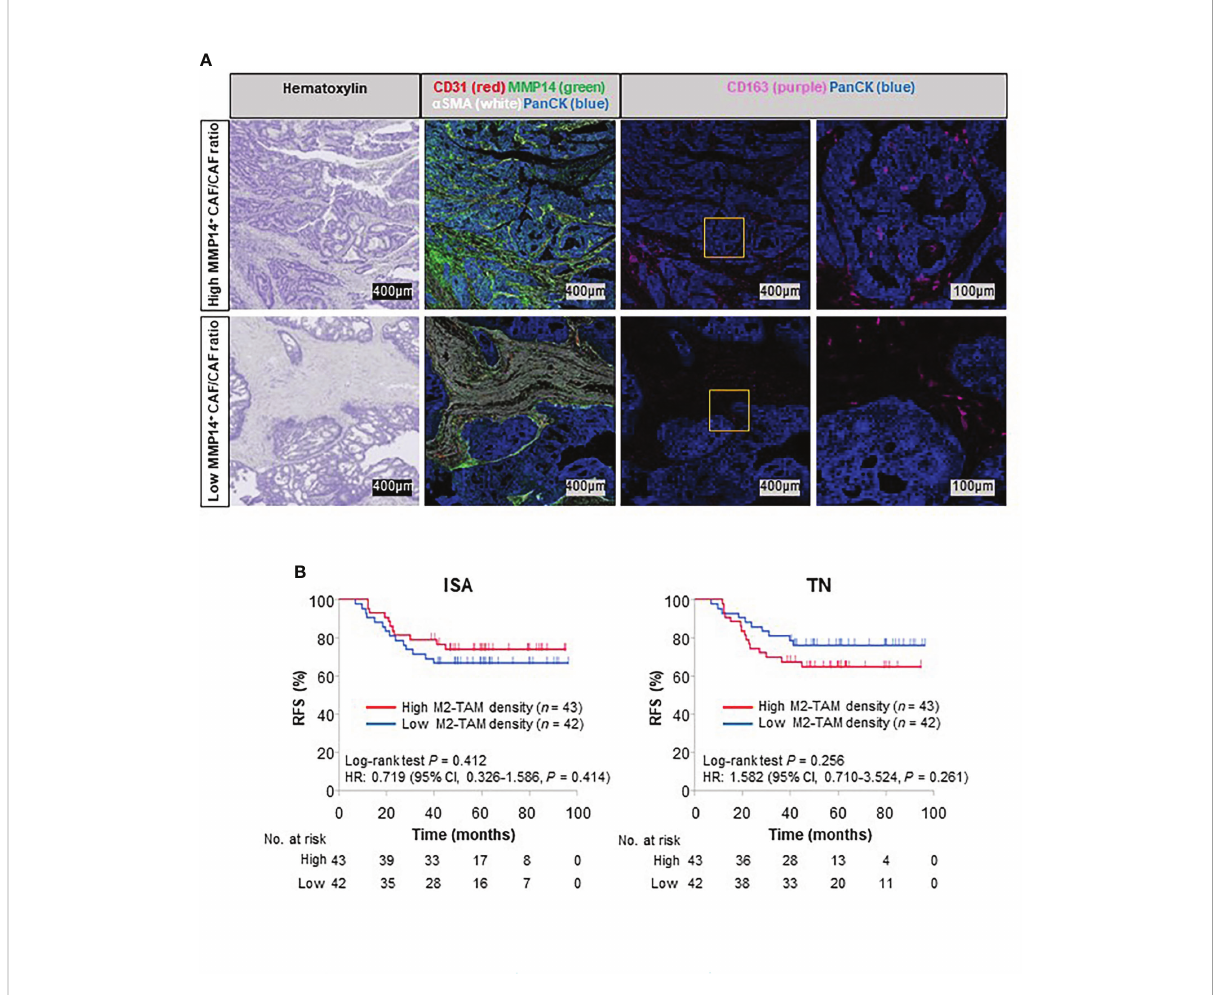
FIGURE 4 Association of M2-TAM distribution in tumors with MMP14 expression in CAFs and survival outcome. (A) Representative mIHC images showing the relation between MMP14-expressing CAFs and the spatial distribution of M2-TAMs. The regions within the yellow squares are shown at higher magni fi cation in the corresponding images to the right. The upper and lower sets of images correspond to patients with a high or low MMP14 + CAF/CAF ratio, respectively. (B) Kaplan-Meier curves for RFS according to the median values of M2-TAM density in ISA (left) or TN (right)